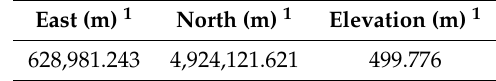
Figure A1. Stability analysis of the Leica GNSS reference station. Daily coordinate solutions computed monthly from December 2016 to July 2019. Table A1. Median value of the coordinate solutions of the Leica reference